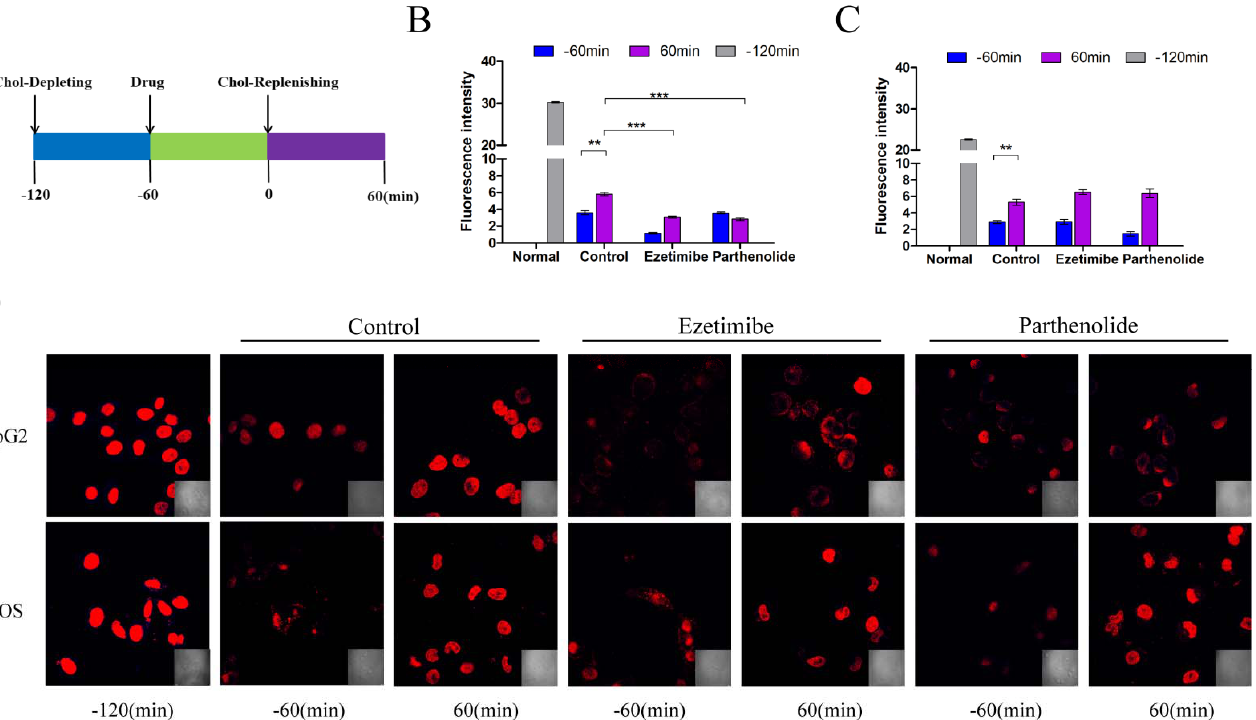
Figure 4. PTL inhibits cholesterol uptake. ( A ) Diagram showing the procedure used to treat the HepG2 and U2OS cells. Briefly, the cells were depleted of cholesterol by incubation in the choles ‐ terol − depleting medium for 60 min. The cells were then incubated for 60 min in the cholesterol − depleted medium containing the indicated drugs. After 60 min, the cells were incubated for 60 min with the cholesterol − supplemented medium containing the indicated drugs. The PTL concentration was 50 μ M and the ezetimibe concentration was 30 μ M. Cells were subjected to staining at various time points. ( B ) Quantification of intracellular cholesterol of the HepG2 cells in ( D ). Error bars represent standard deviations. ( C ) Quantification of intracellular cholesterol of the U2OS cells in ( D ). Error bars represent standard deviations. ( D ) HepG2 and U2OS cells were treated as shown in ( A ). Cholesterol was labeled with filipin stain and examined using a high − resolution, high − speed scanning confocal microscope. Scale bar = 20 μ m. (** p < 0.01, *** p < 0.001 compared to